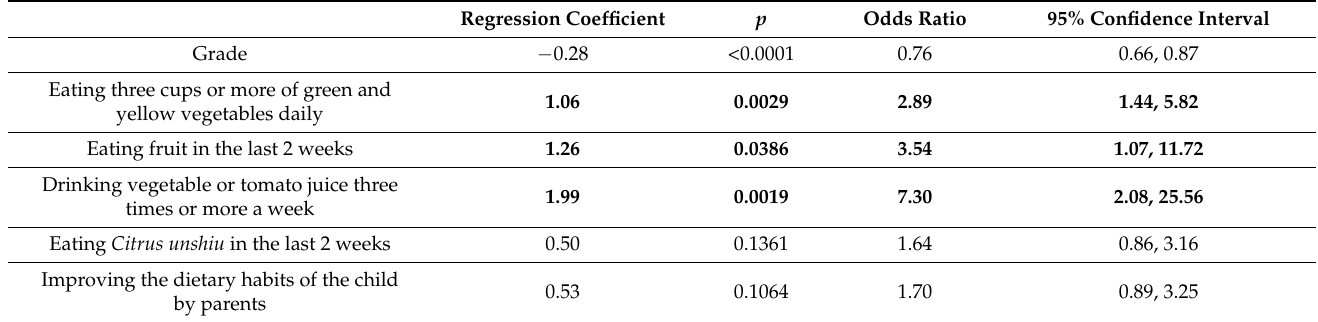
Table 6. Significant variables in the multivariate logistic regression analysis with model selection for factors exceeding the average Veggie Meter